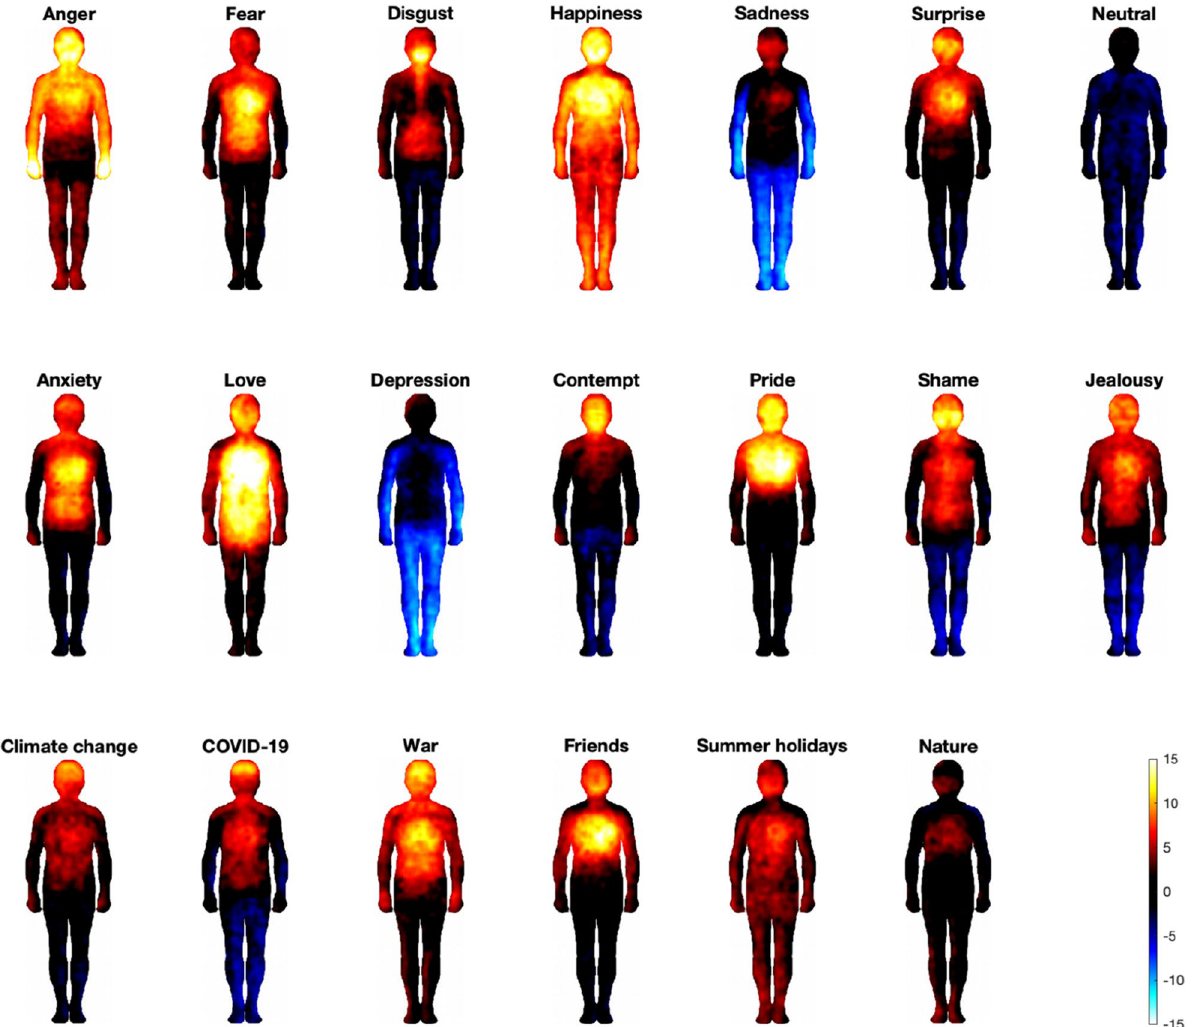
Figure 4. Bodily topography of basic (Upper) and complex (Middle) emotions and sensations related to phenomena (Lower). The body maps show regions whose activation increased (warm colours) or decreased (cool colours) when feeling each emotion or thinking of each phenomenon ( p < 0.05 FDR corrected; t > 2.95). The colour bar indicates the t-statistic